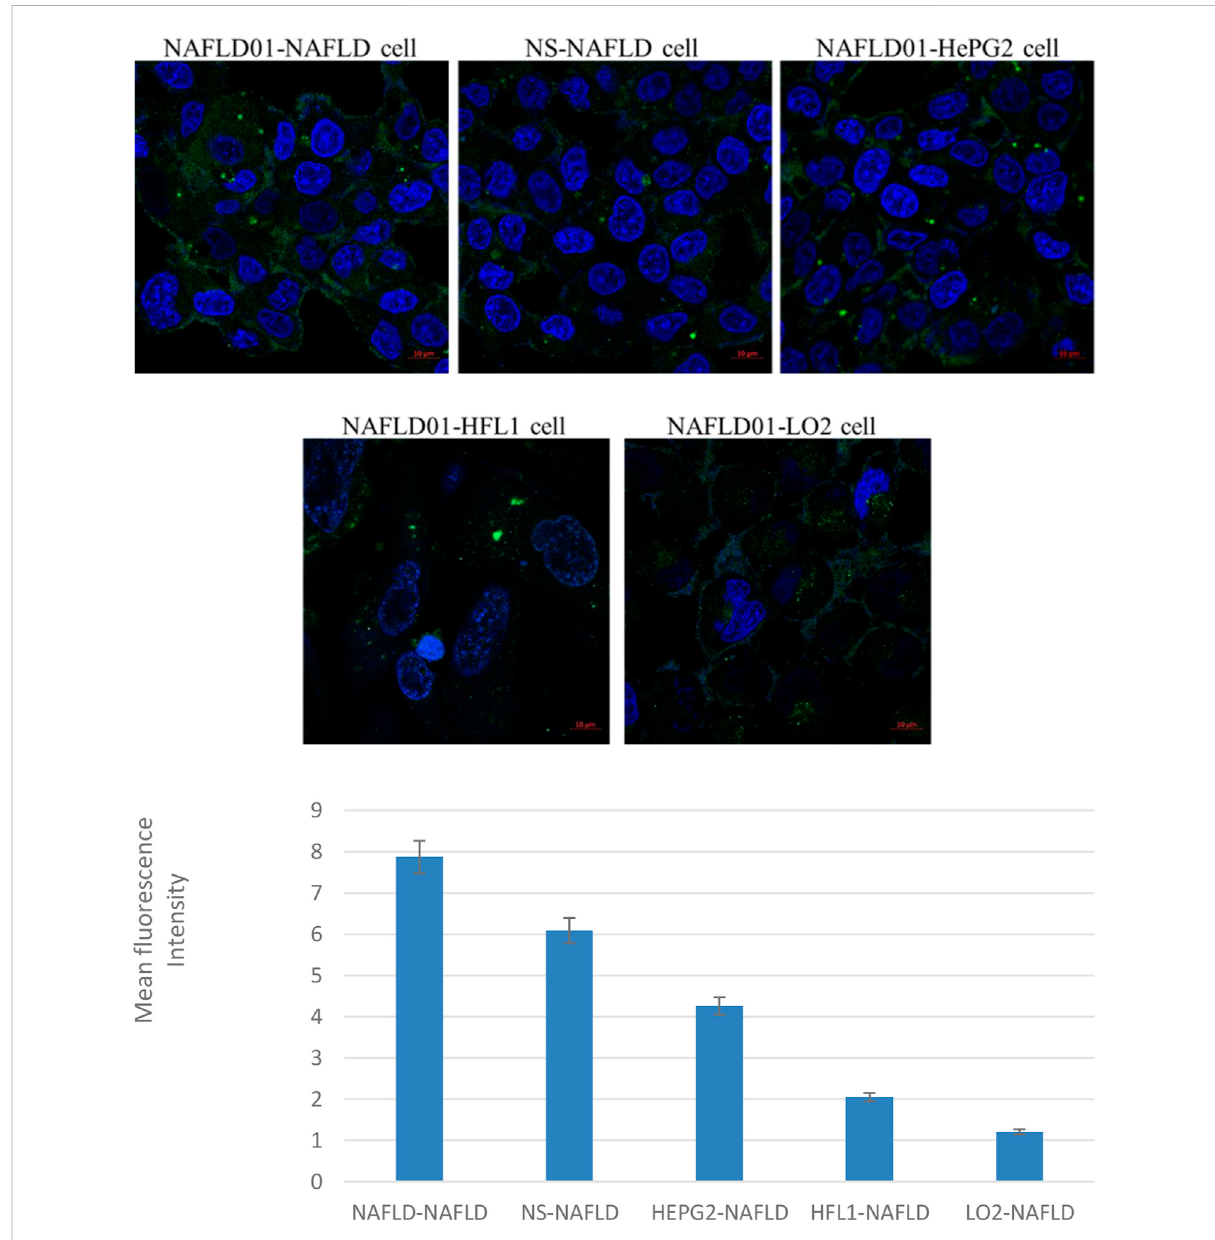
Confocal fl uorescence veri fi esthat aptamers can target NAFLD cells. Comparedto HePG2 cells, LO2 cells, and HFL1 cells, NAFLD cells showed stronger green fl uorescence signals. In addition, stronger green fl uorescent signals were also shown around NAFLD01-NAFLD cells compared to NS-NAFLD cells. Quanti fi cation analysis of fl uorescence intensity of the fi ve groups (* p <